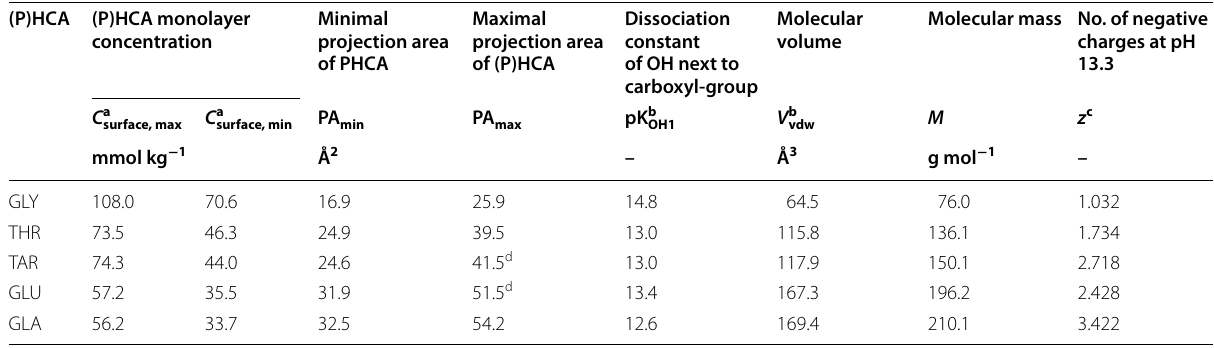
a Calculation based on maximal/minimal projection area, respectively b From [33] c Calculation based on dissociation constants of functional groups